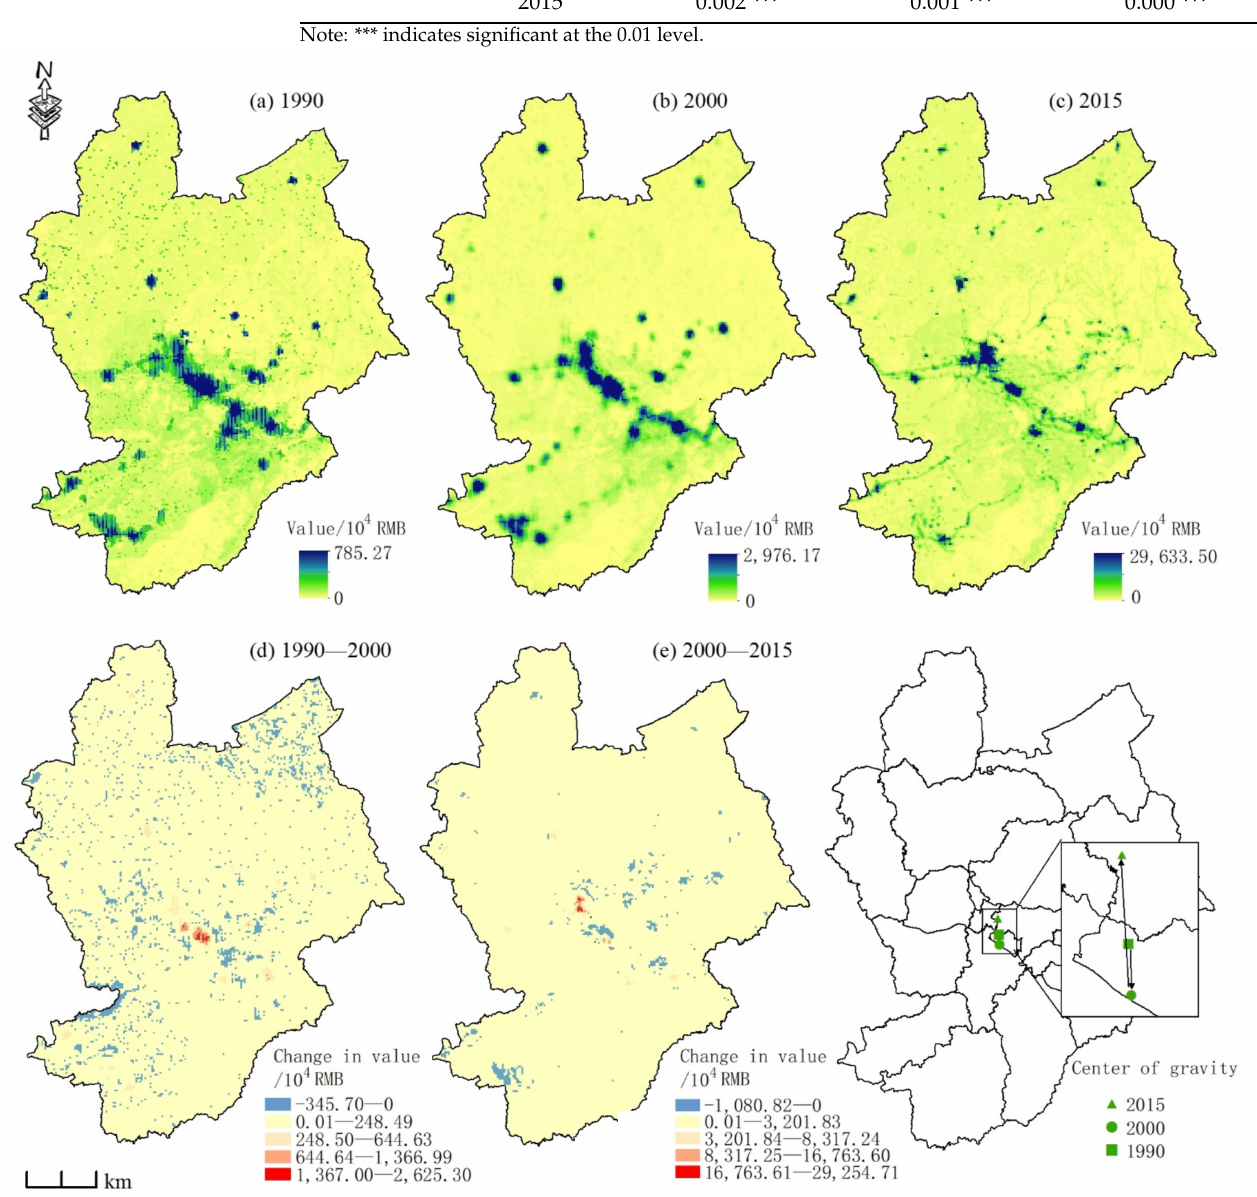
Figure 3. Spatial evolution of land use economic function at grid scale in Zhangjiakou City